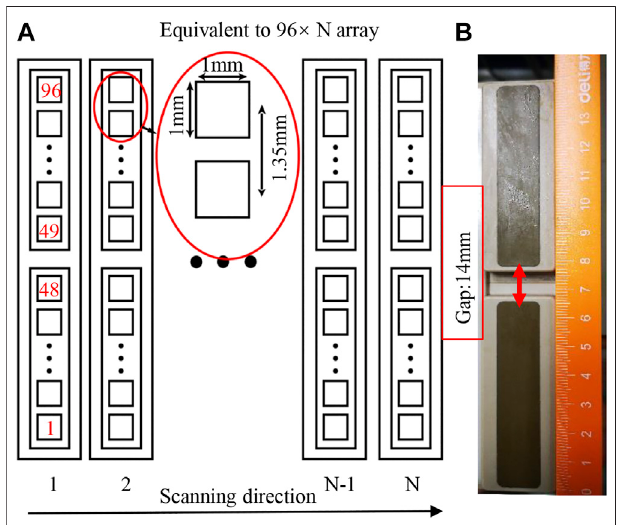
FIGURE 2 | (A) Schematic diagram of the probe as well as the scanning scheme; (B) photograph of the combined probe consisting of two linear